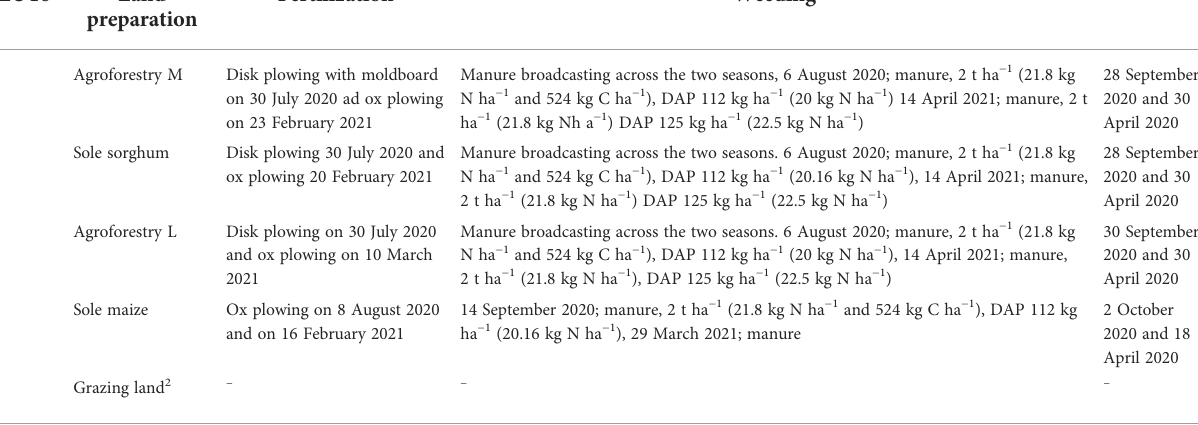
TABLE 1 Farm management practices in different land utilization types in Siaya County, Kenya. LUTs